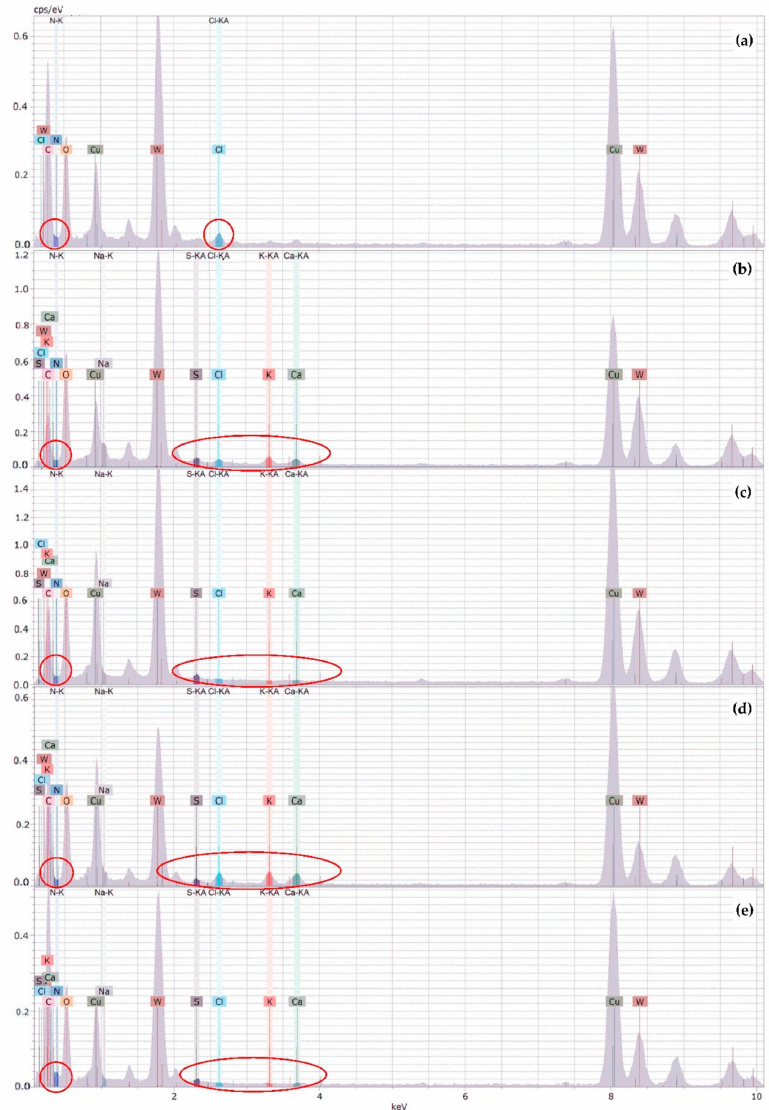
Figure 4. XEDS spectra of ( a ) NE; ( b ) NE- κ -CAR; ( c ) NE( κ -CAR/CS) 1 ; ( d ) NE( κ -CAR/CS) 1 - κ -CAR; and ( e ) NE( κ -CAR/CS) 2